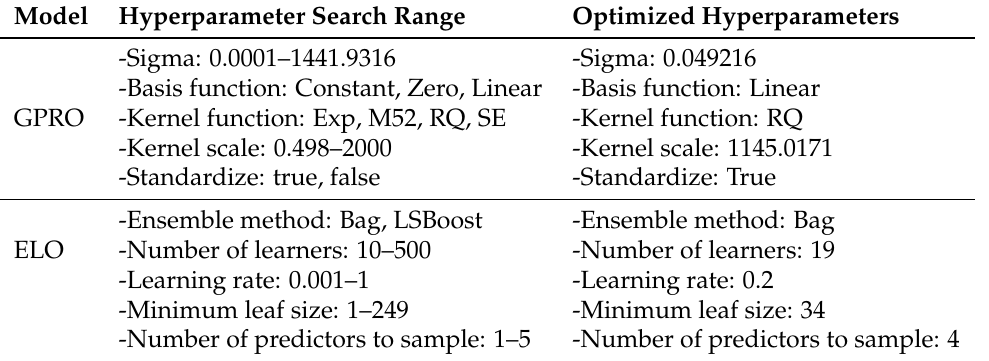
Table 3. Hyperparameters search range and optimized hyperparameters using the BO algorithm.